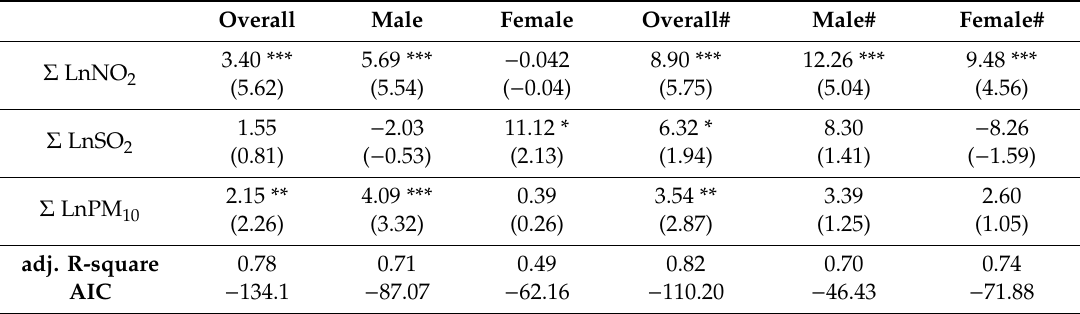
Table 3. Cumulative health effect of air pollution on NPC incidence and its growth rate.